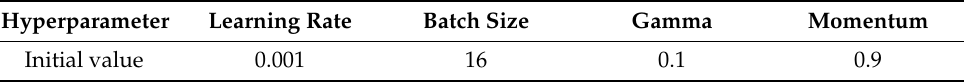
Table 5. Hyperparameter settings.